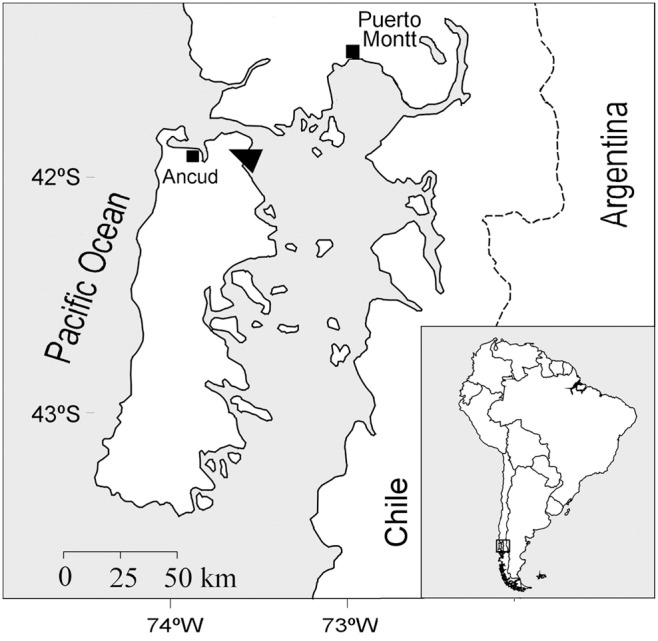
Location of study site (triangle) on northern Chiloé Island, Chile.